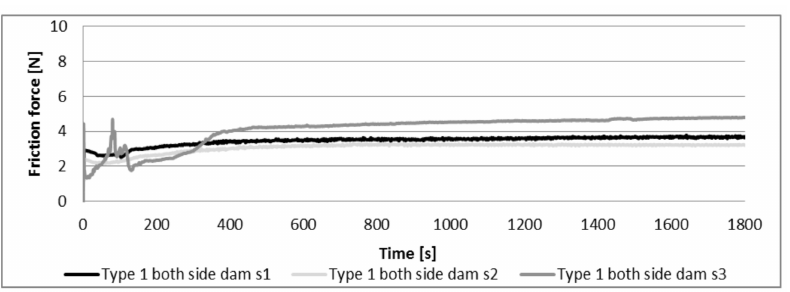
Figure 8. Friction force versus time for assemblies with a textured disc of type